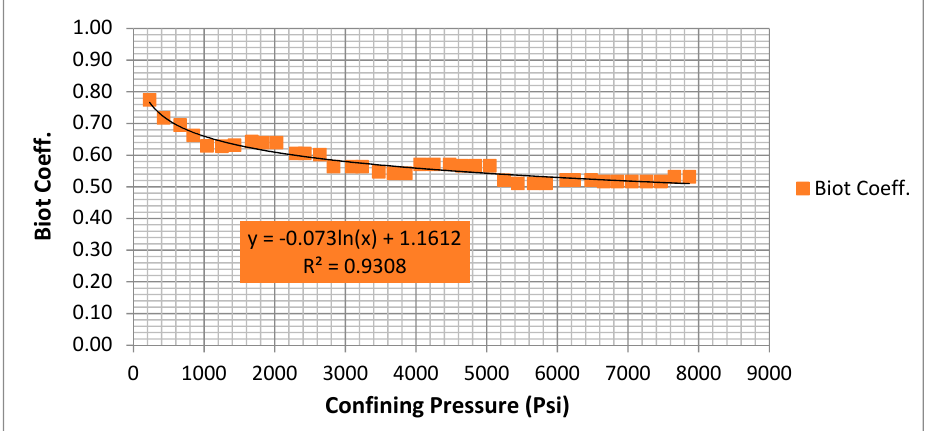
Figure 13. Biot coefficient vs. confining pressure for C6.